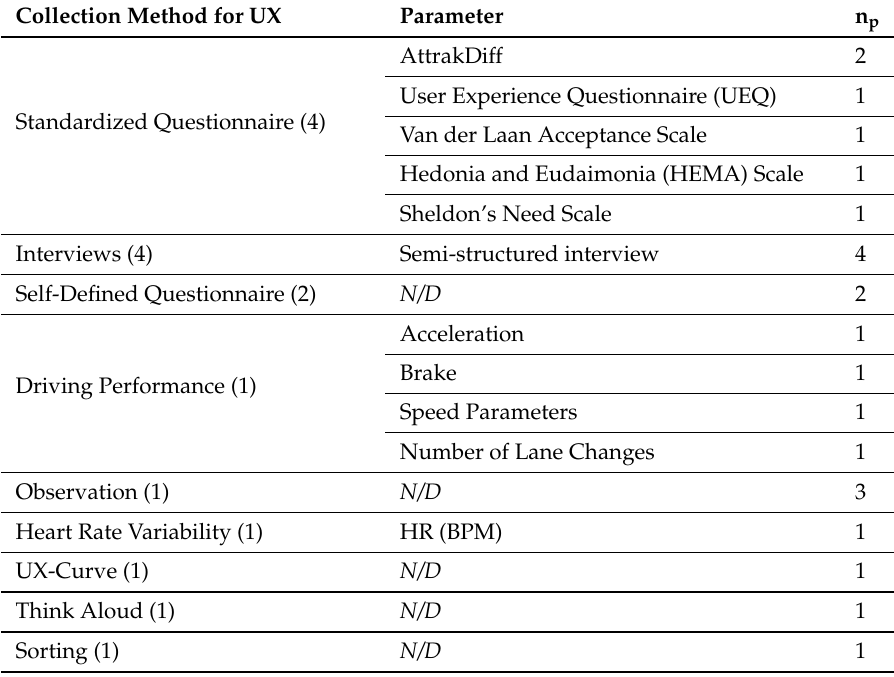
Table 11. UX collection methods and